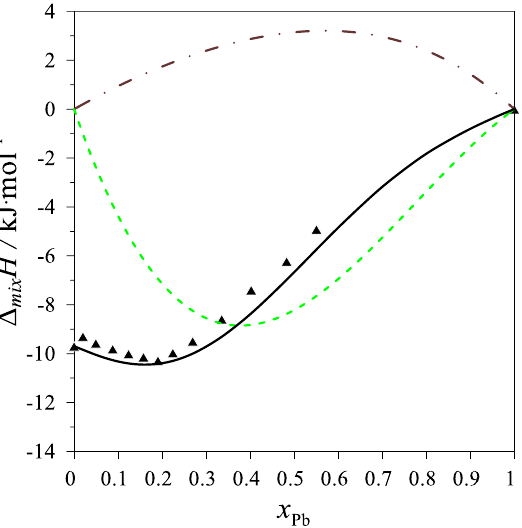
Figure 3. The integral mixing enthalpy of Ag – Mg – Pb liquid solutions for the intersection (Ag 0.25 Mg 0.75 ) 1−x Pb x at 1116 K. Black line: data calculated with Equation (4), black triangles — experi- mental data. The dashed green line is the integral molar mixing enthalpy of Mg – Pb liquid alloys [12], and the brown dash-dotted line is the integral molar mixing enthalpy of Ag – Pb liquid alloys [17].